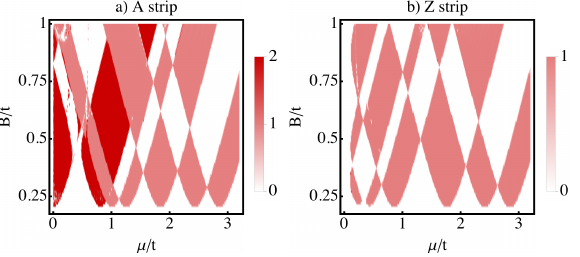
Figure 4: The total MP as a function of the chemical potential and magnetic field for A strips (left panel) and Z strips (right panel). We take W = 5 a , L = 520 a , α = 0.1 t and ∆ = 0.2 t .